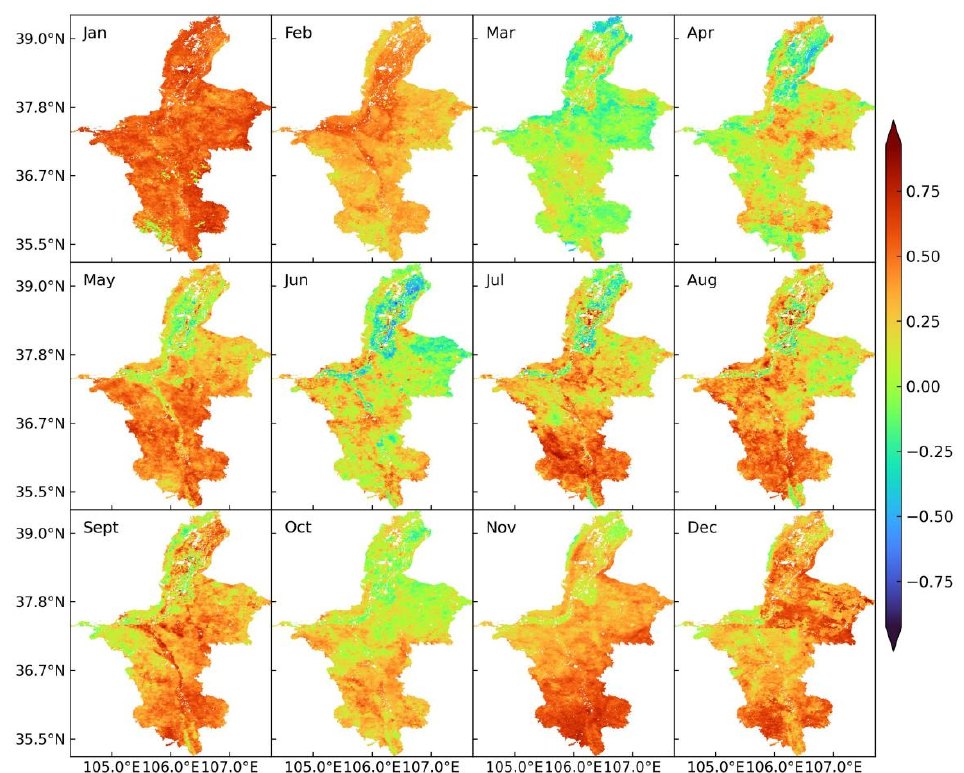
Figure 13. Spatial distribution of the correlation coefficient between EDI and land surface temperature.